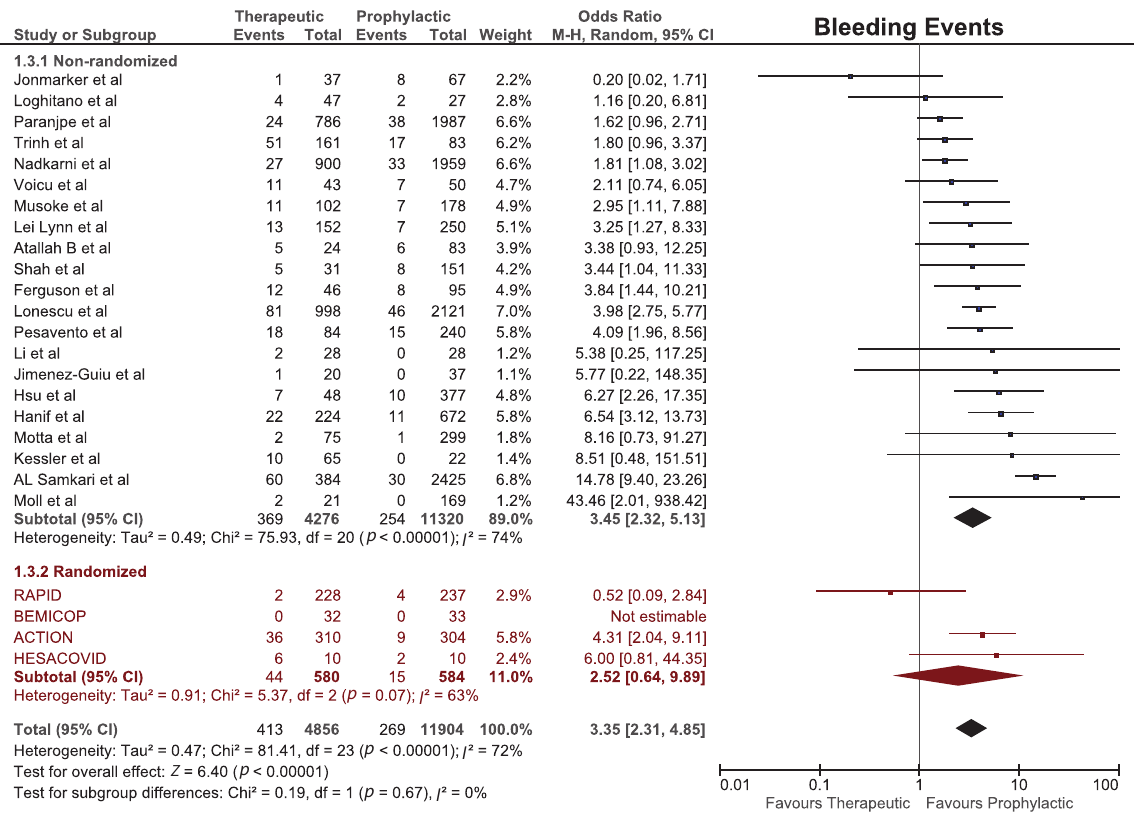
Fig. 4 Forest plot for bleeding events with therapeutic versus prophylactic doses of anticoagulation. CI, con fi dence interval.